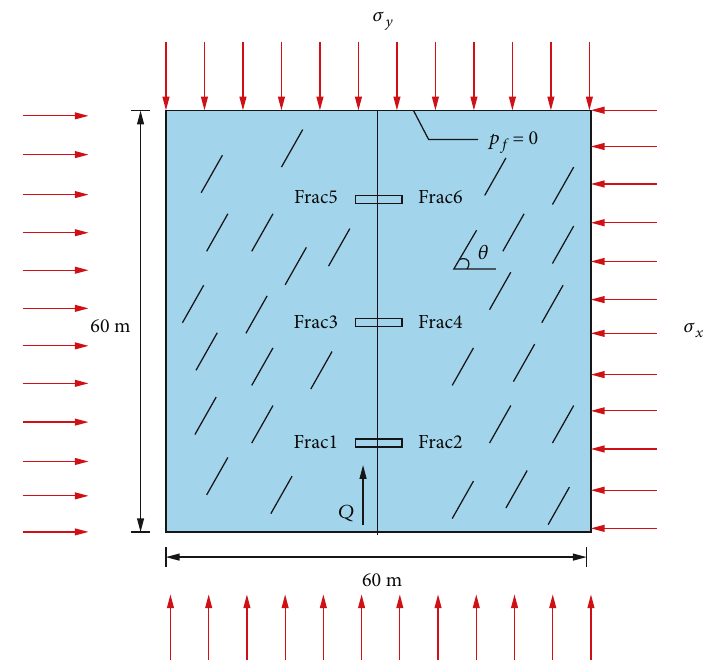
Figure 6: Schematic diagram of multicluster